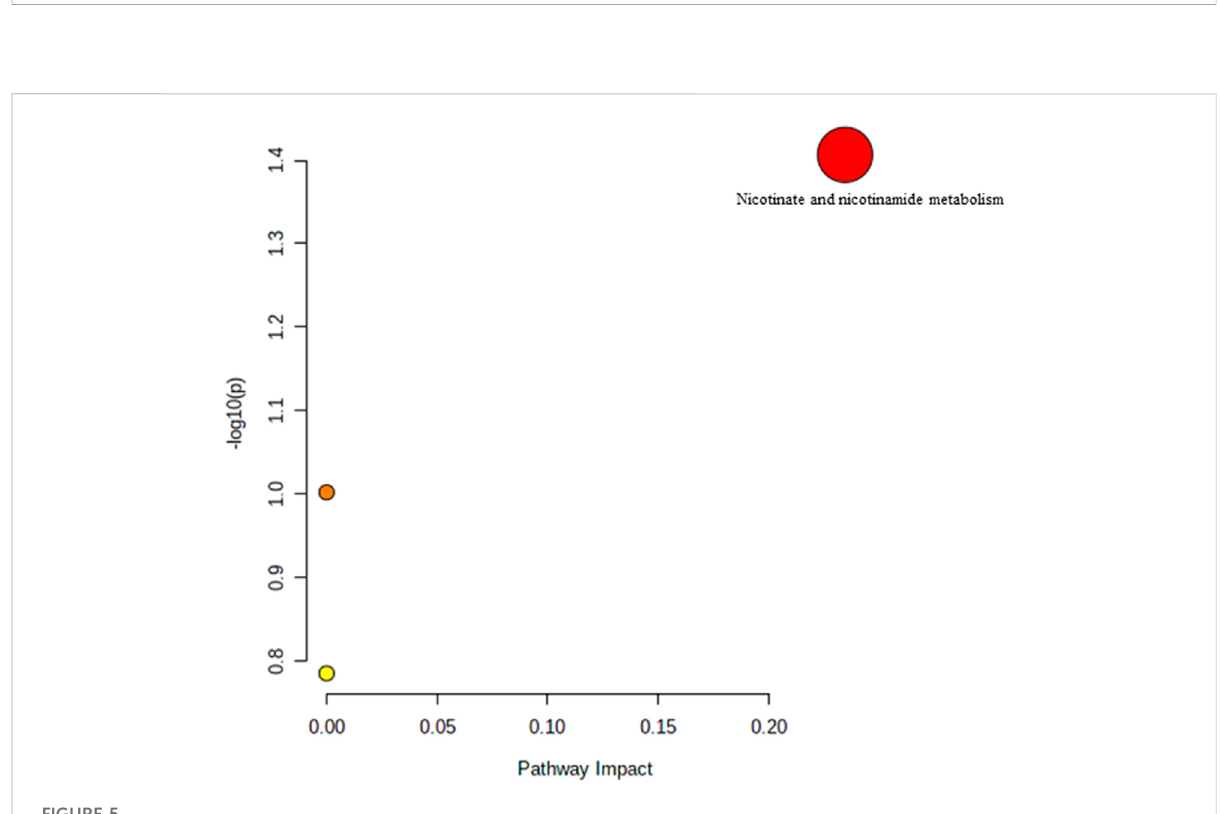
FIGURE 5 Biochemical pathway analysis of metabolites pro fi led for YC vs. YT.